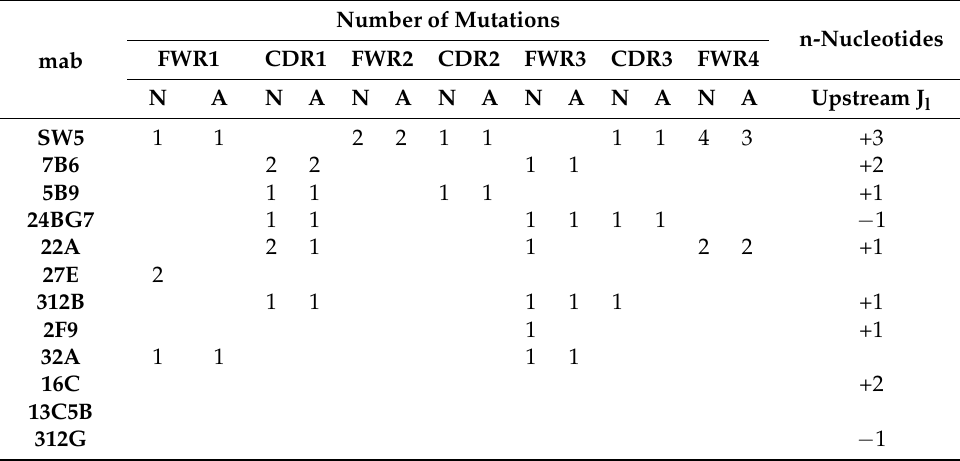
Table 2. Analysis of mutation rate calculated for the respective light chain. The sequences of the V l domains listed in Table 1 were compared and the number of mutations were calculated which occurred at the nucleotide (N) or amino acid level (A). Additional or missing nucleotides upstream of the J I element are also given (n-nucleotides). The primer dependent first 24 nucleotides were not included in the analysis.